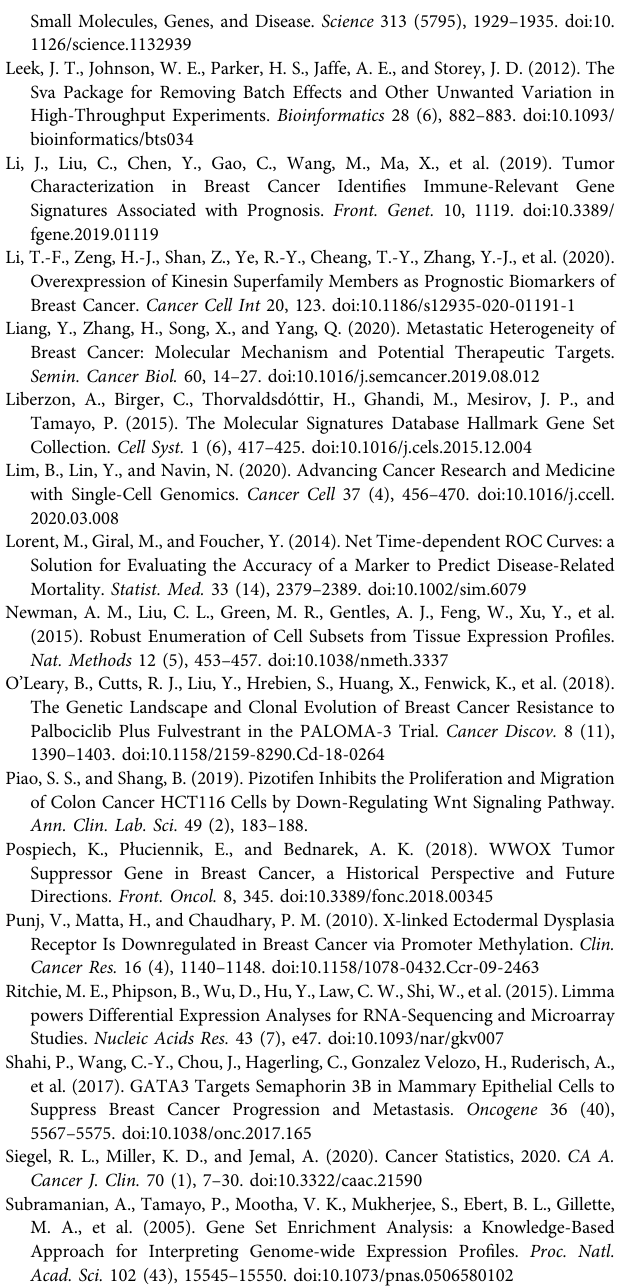
Supplementary Table 1 | The list of 1217 tumor suppressor